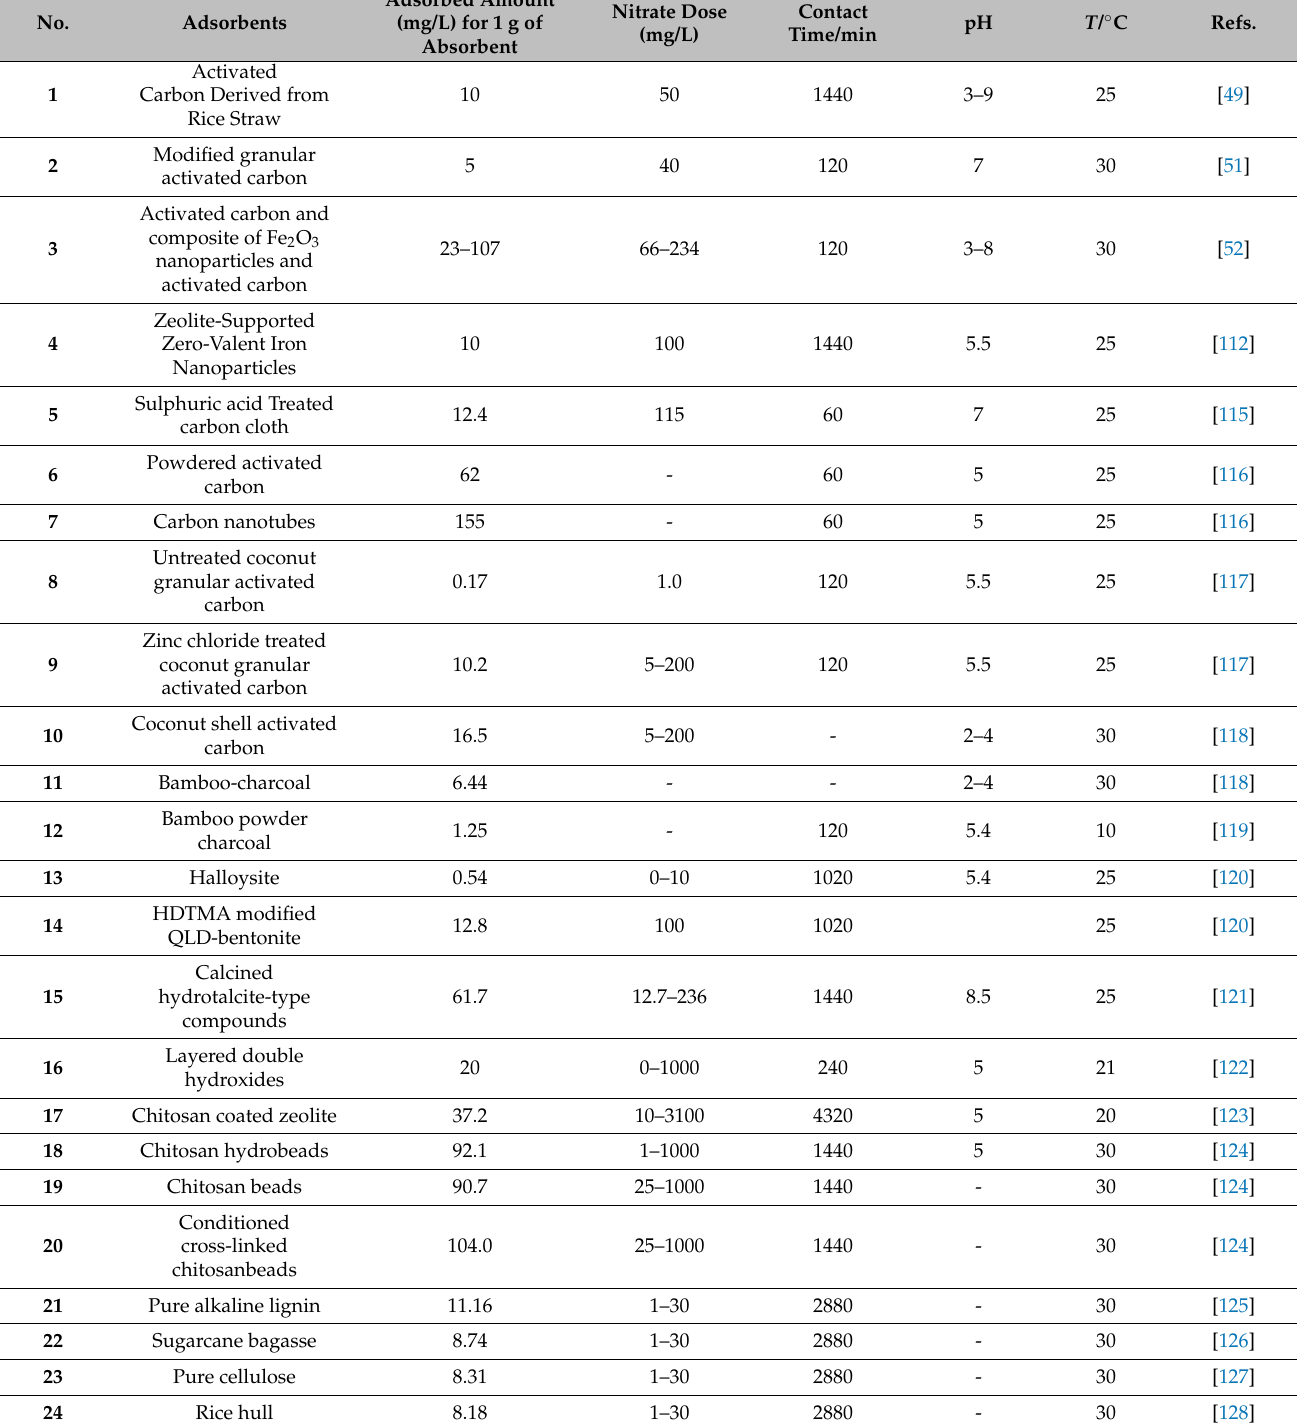
Table 1. Optimum parameters for nitrate removal by different